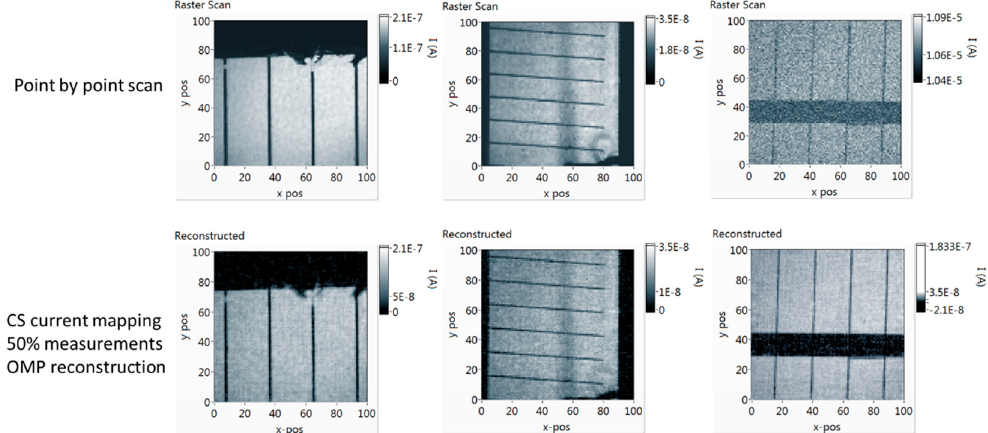
Figure 7. Current maps of the three samples used in this work, with the c-Si reference cell on the left, the OPV in the middle, and the large mc-Si cell on the right. In the top row, point-by-point current maps of the three samples. In the bottom row, CS current maps of the three samples, using the orthogonal matching pursuit (OMP) algorithm for reconstruction and for 50% undersampling .